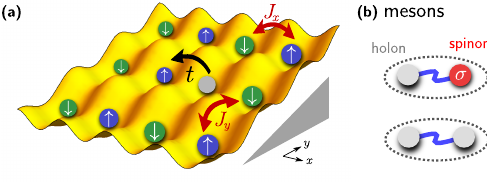
Figure 1: Mixed-dimensional t − J model. We consider ultracold spin-1 /